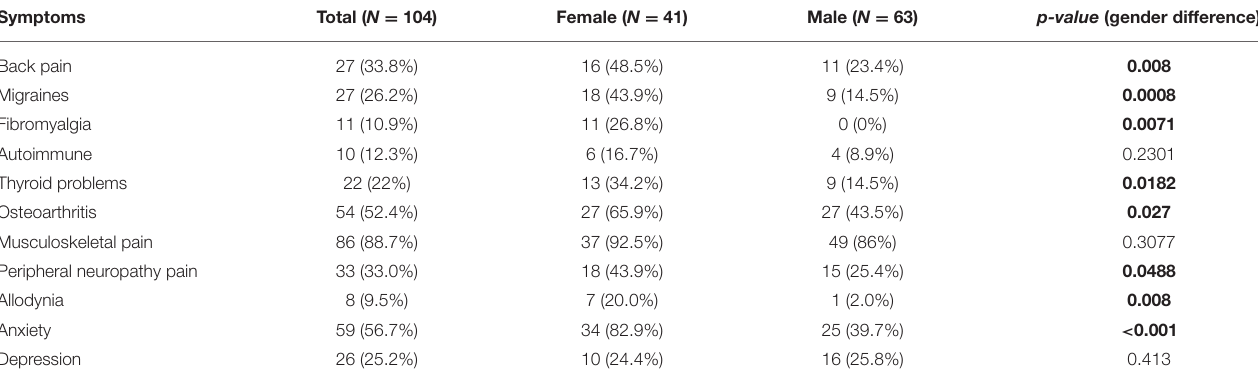
TABLE 3 | Prevalence [N of Yes (%)] of symptoms (Yes/No).